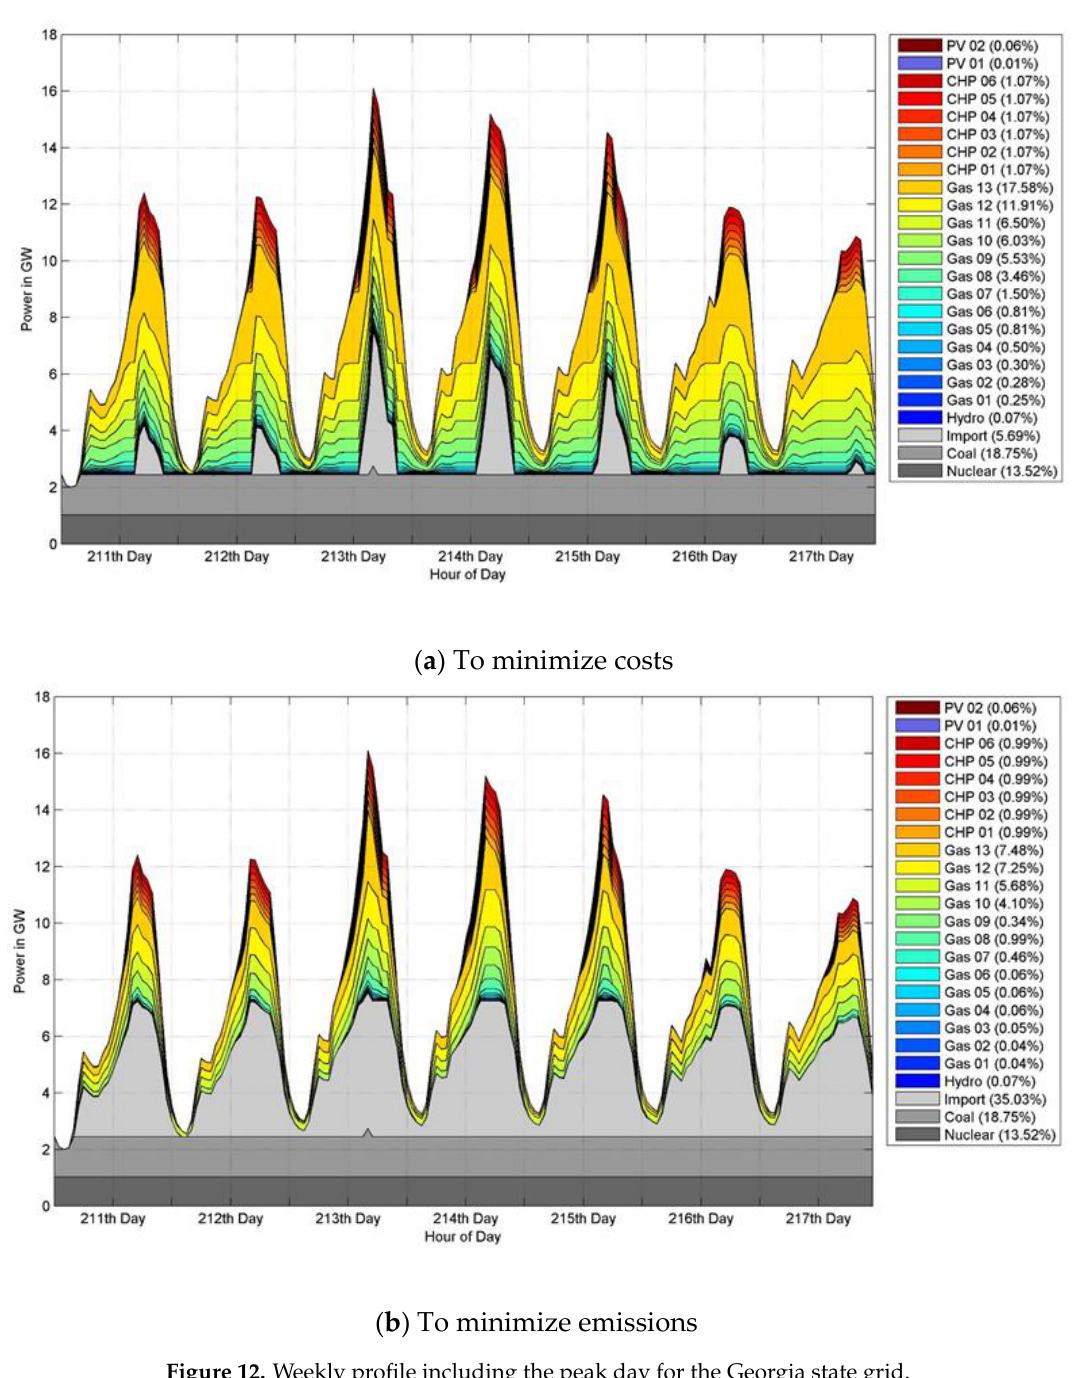
Table 1. Generation costs for Atlanta area as input [25–27].